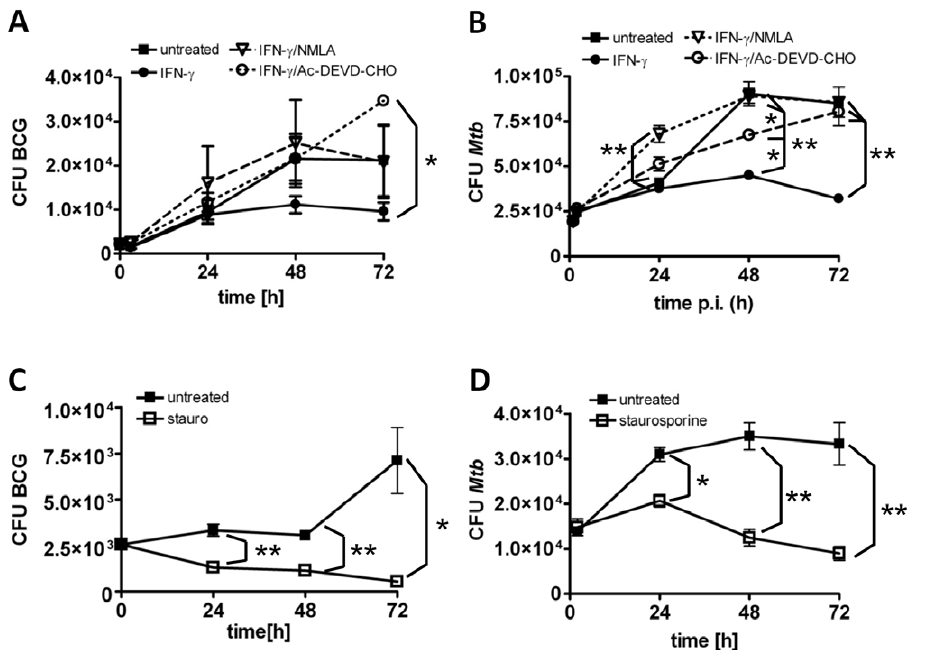
Figure 4. NO induced apoptosis is responsible for the growth restriction of intracellular mycobacteria in IFN- c activated macrophages. Resting or IFN- c activated (2000 U/ml O/N) B6 (A, C and D) or TLR2/4/9 KO (B) BMM W were infected with BCG (MOI 10; A, C) or M. tuberculosis (MOI 1; B, D) for 1 h, and subsequently treated with NMLA (1 mM) or caspase 3/7 inhibitor (Ac-DEVD-CHO, 100 m M). Staurosporine (1 m M) was used to induce apoptosis. To determine mycobacterial survival, macrophages were lysed every 24 h and serial dilutions were plated onto agar plates for CFU determination. Data from one representative experiment out of two, respectively, are shown as means 6 SD of triplicate cultures. Statistical analysis was performed by ANOVA (* p , 0.05; ** p ,